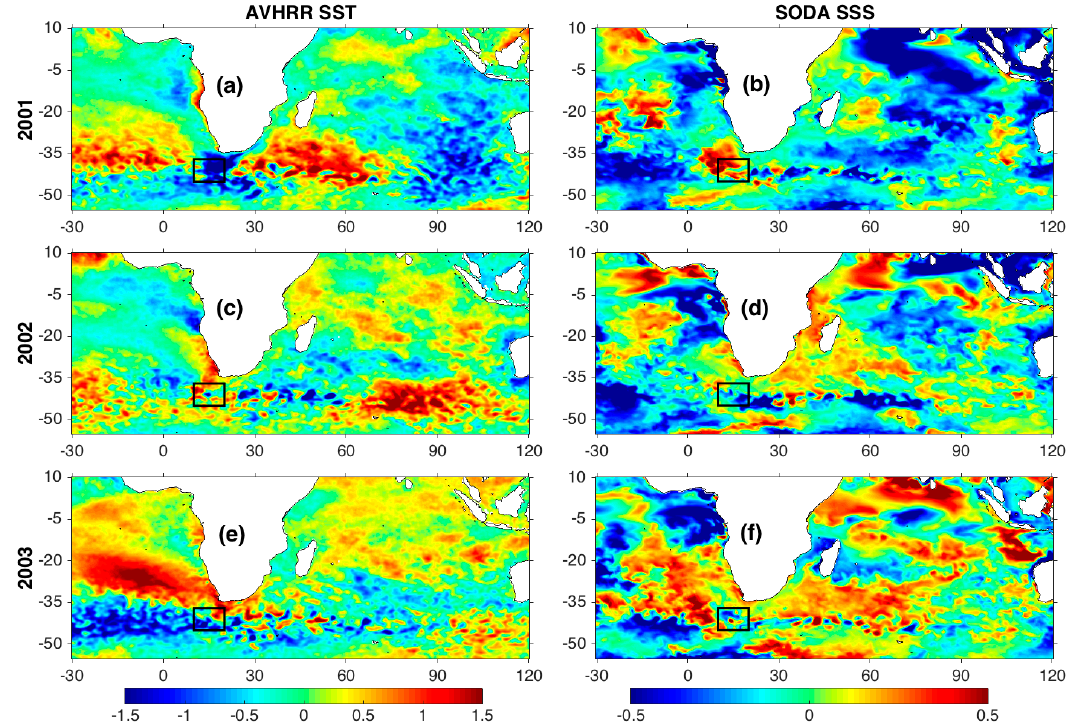
Figure 6. Same as Figure 4 except in reference to the weak 2000–2001 La Niña event during the peak ( a , b ), the following year ( c , d ), and two years after ( e , f ).